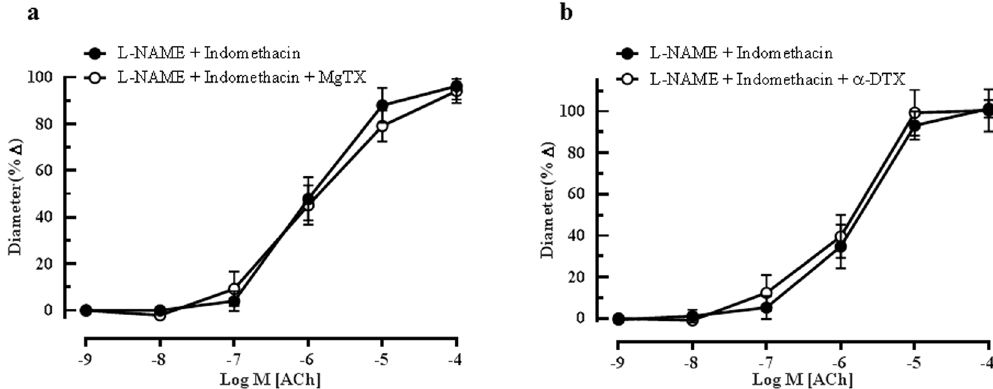
Figure 7. Effect of K v channels inhibition on EDHF-mediated relaxation of ophthalmic artery. Blocking of vessels with ( a ) MgTX and ( b ) α -DTX demonstrated non-significant inhibitory effects on the ACh-mediated vasodilation. Values are expressed as mean ± s.e.m (n = 5–6 per group).